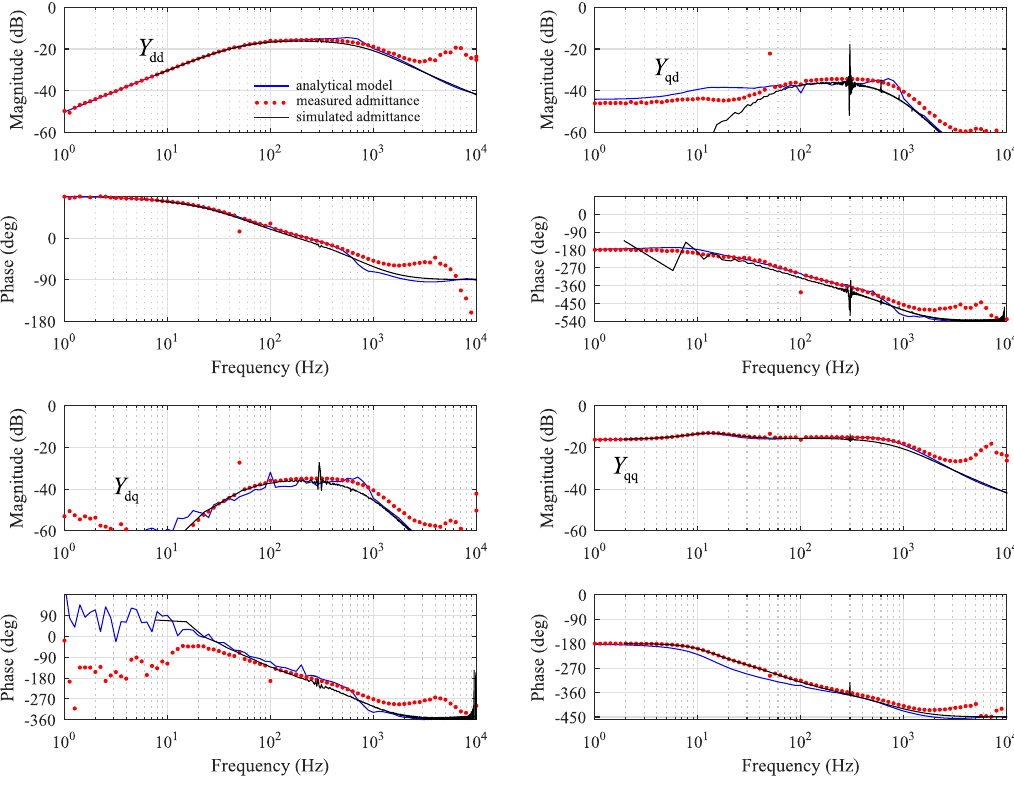
Figure 12. Comparison of expected and measured